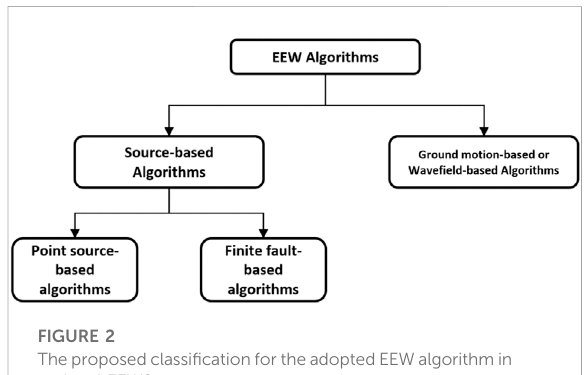
FIGURE 2 Theproposedclassi fi cationfor theadoptedEEW algorithm in regional